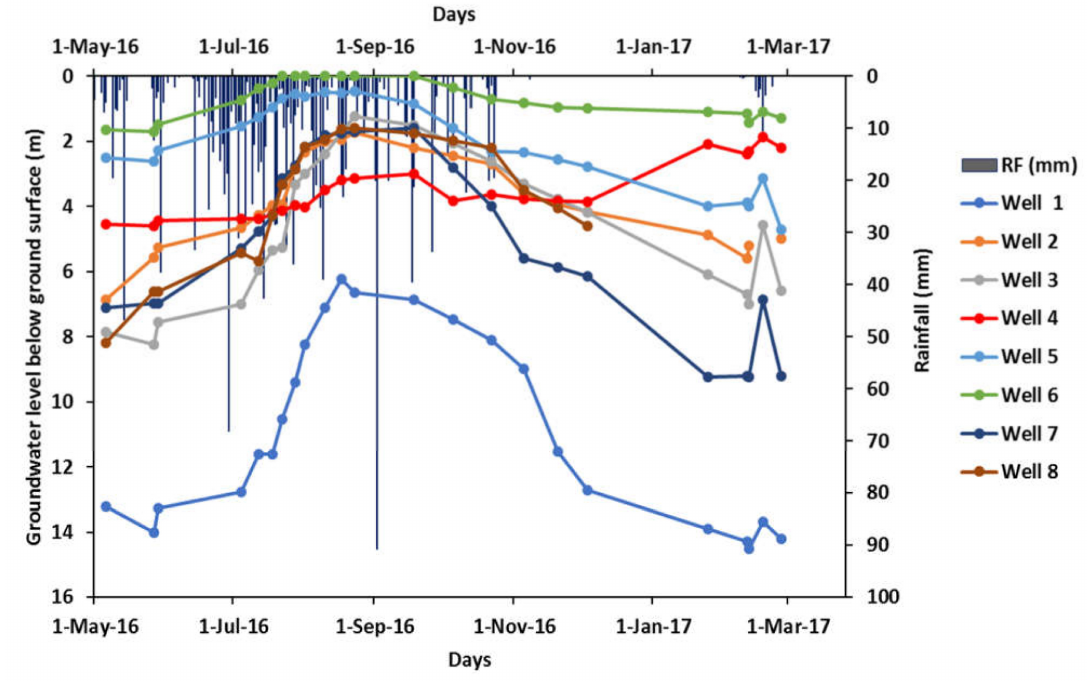
Figure 6. Groundwater level fluctuation within the Infranz catchment in response to the wet and dry season, with an indication of daily rainfall (the striking peaks in February were registered on 18 / 02 /